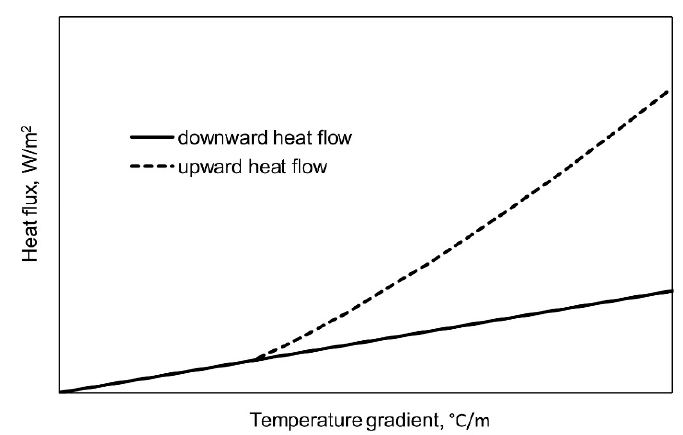
Figure 4. Typical experimental results of natural air convection tests.